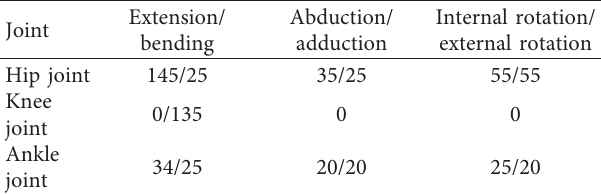
Table 1: Range of rotation angle of each joint of lower limbs.